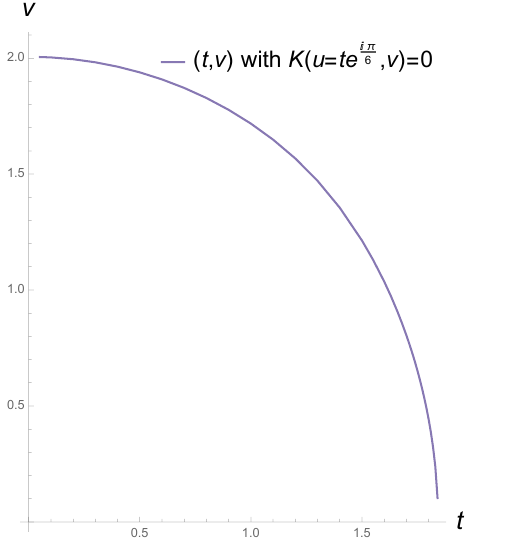
(b) Plot of the (approximately, but not exactly ellipse-shaped) K = 0 contour in the ( t, v ) plane, for various real values of t and v , with u = te iπ 6 . The curve is made up of 36 data points, and v . is symmetric under v → − Figure 5. Plots of K made using the numerical techniques of appendix